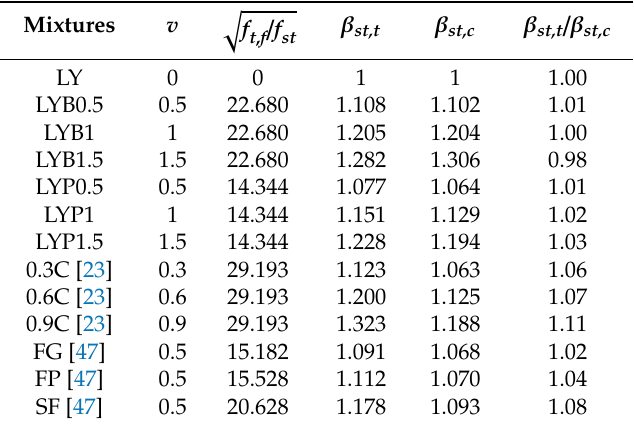
Figure 14. The fitting effect of β st . Table 6. Comparison of test and calculation results of β st.